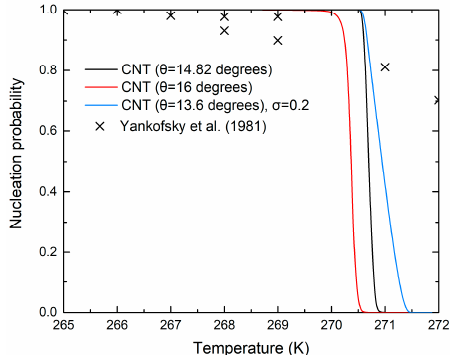
Figure 4. IN nucleation probability versus temperature for bacterial samples (M1, r p = 750 nm) using different contact angles, a log-normal distribution of contact angles, and comparison with the laboratory experimental data of [35,36].